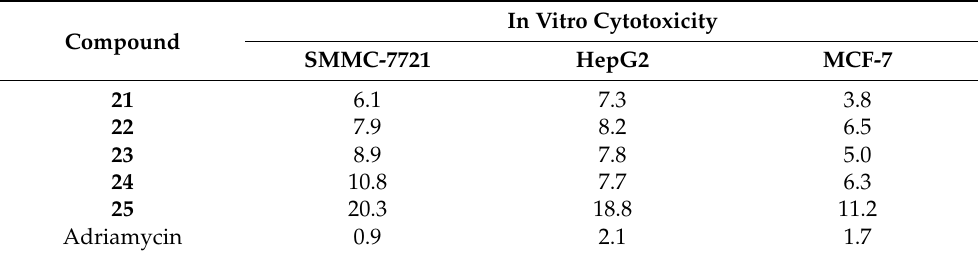
Figure 8. Chemical structure of the of furoxan–cinnamic acid hybrids 21 – 24 and furoxan moiety 25 with anticancer activity [46]. Table 5. The in vitro antitumor activity of compounds 21 – 25 against hepatocellular carcinoma and human breast cancer cells (IC 50 in μ M) [47].